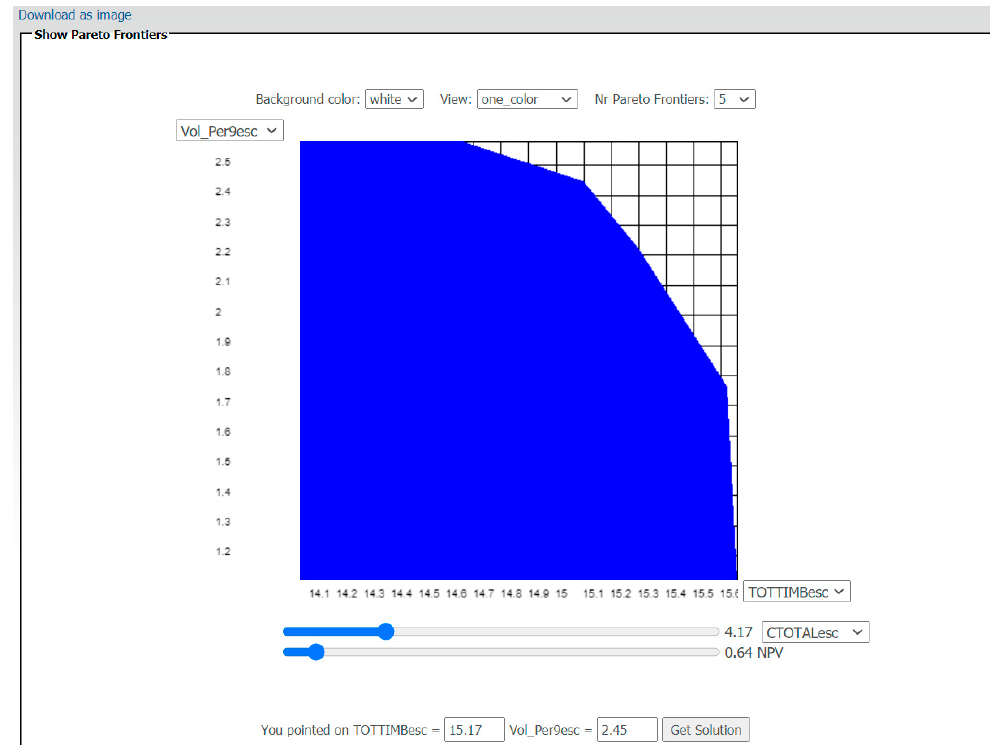
Figure 10. Interactive decision map showing the tradeoff between four criteria: volume of ending inventory (10 6 m 3 ; Vol_Per9esc) in the y -axis; total wood (10 6 m 3 ; TOTTIMBesc) in the x -axis; the chosen level of average carbon sequestered (Mg year − 1 ; CTOTALesc) in the first slider (4.17 Mg year − 1 ) and the chosen level of net present value level (10 8 EUR; NPV) in the second slider (0.64 10 8 EUR).